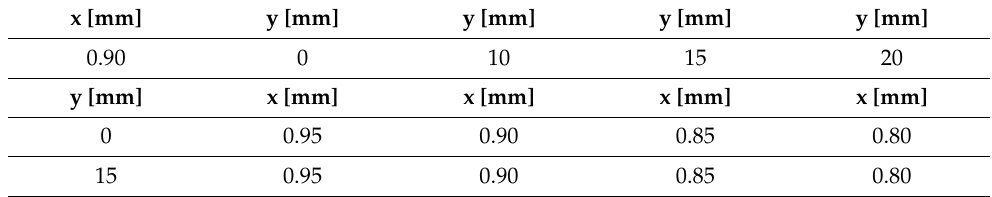
Figure 3. Considered initial profiles of blank thicknesses. Table 1. Values of x and y parameters considered to design the initial profile of the blank.